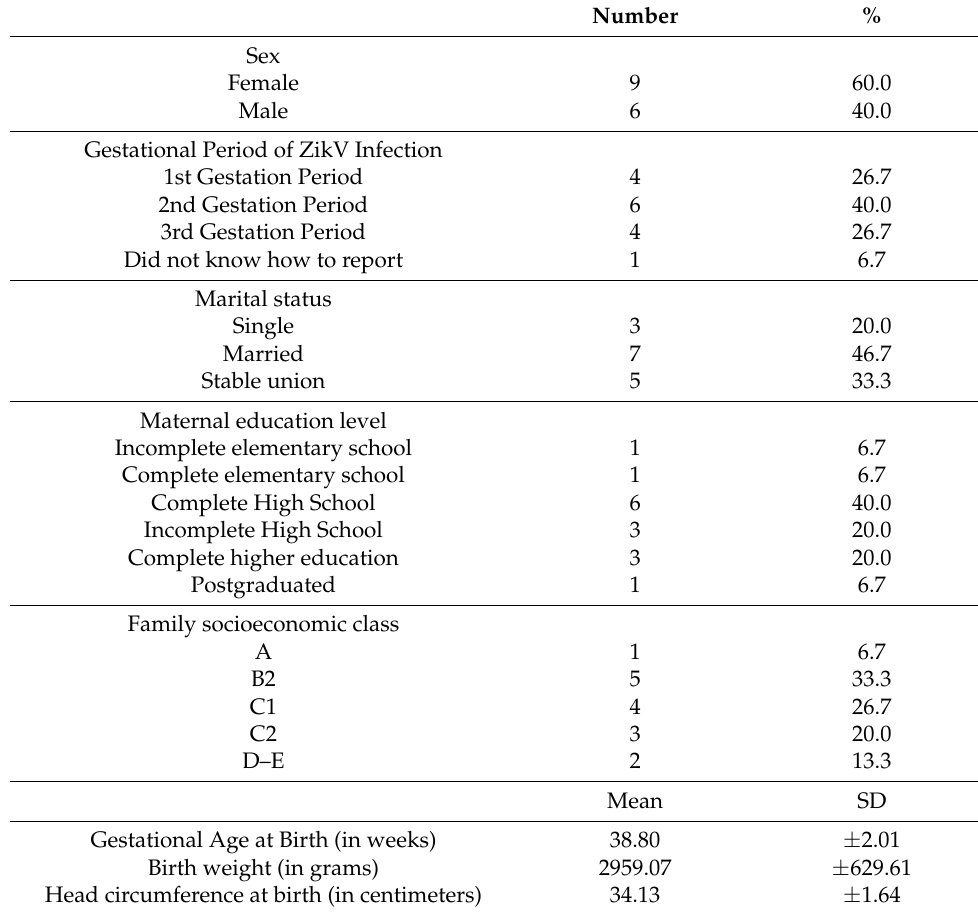
Table 1. Characteristics of the study participants ( n = 15).